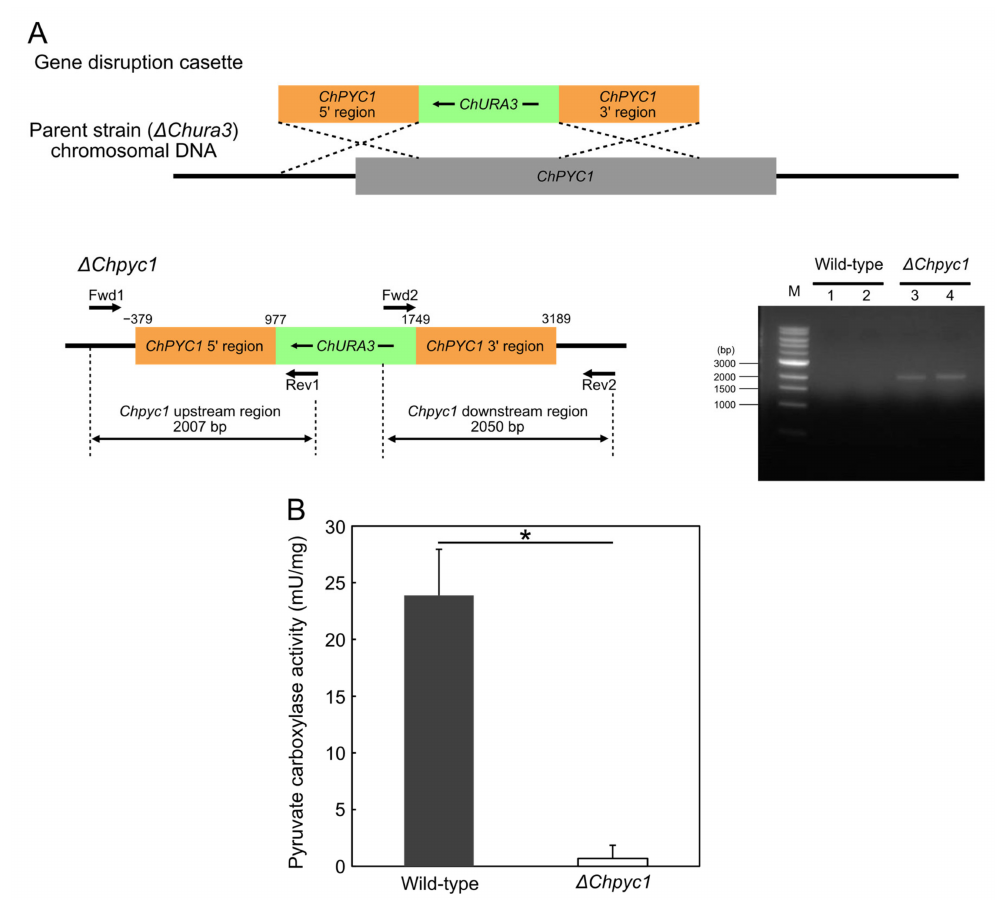
Figure 3. Construction of ∆ Chpyc1 strain, and pyruvate carboxylase activity of the crude extract from the wild-type (strain UJ1) and ∆ Chpyc1 strains of C. humicola . ( A ) Schematic representation of ChPYC1 gene disruption by homologous recombination using ChURA3 gene and PCR analysis of the gene disruption. The numbers above the box indicate the distance (bp) from the start codon ATG of the chromosomal ChPYC1 gene. ChURA3 gene was inserted into the ChPYC1 gene between 977 and 1749 bp in the opposite direction. Lanes 1 and 2, the negative control amplification of the upstream and the downstream regions, respectively, in the wild-type strain; lanes 3 and 4, the amplification of the upstream and downstream regions in ∆ Chpyc1 strain. PCR was performed using ∆ Chpyc1 -specific primer pairs. ( B ) The activity was measured by the same method as described in Figure 3. Statistical differences were ascertained by Welch’s t -test, * p < 5 × 10 − 2 . The values are the means of three independent experiments, and the error bars represent the standard